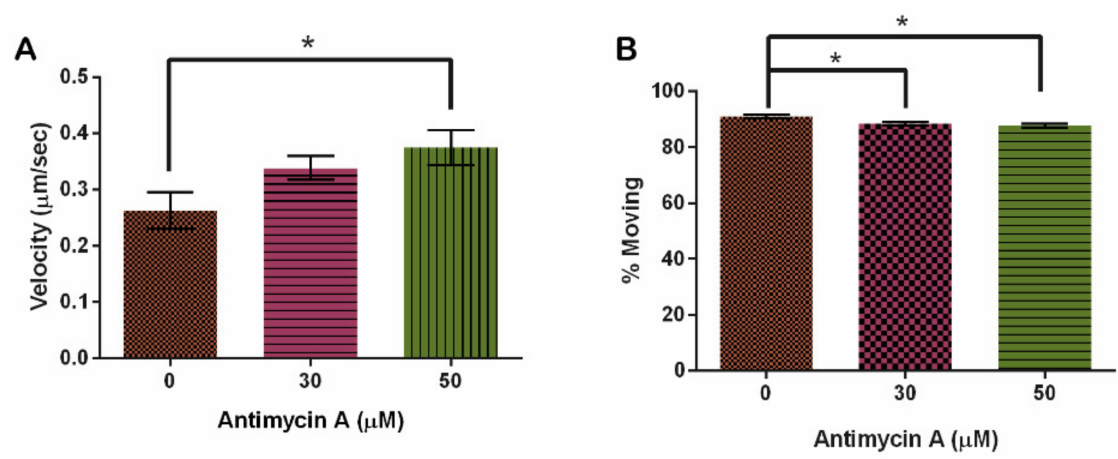
Figure 10. Effect of Antimycin A on mitochondrial motility. ( A ) AMA significantly increases mitochondrial velocity and ( B ) has a significant effect on the number of mitochondria moving (n = 30 cells, p = 0.0436 and 0.0041, respectively). Columns are averages, error bars represent the standard error and * indicates